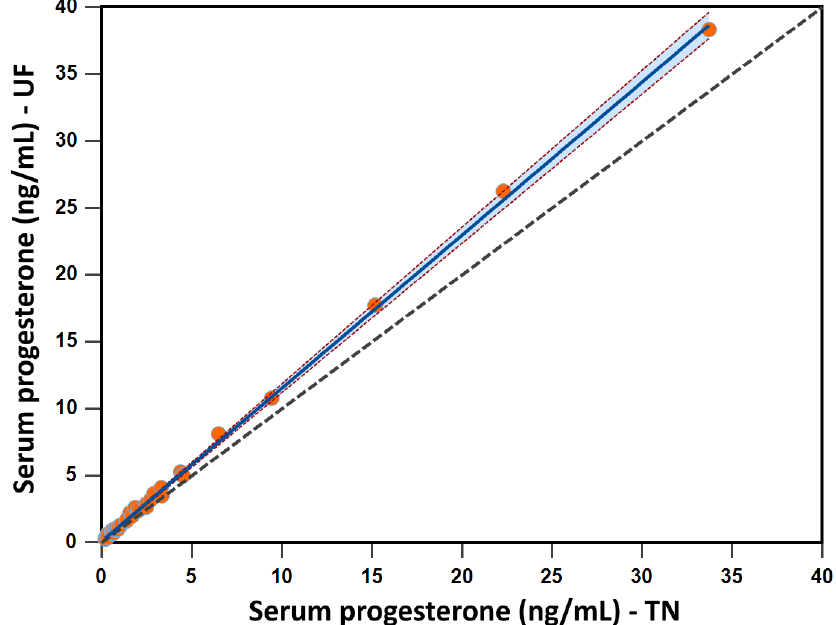
Figure 4. Scatterplot indicating the relationship between the serum progesterone concentration measured by the IMMULITE ® 2000 XPi P4 immunoassay at the University of Florida (UF) and the University of Tennessee (TN). The grey dashed diagonal line is the line of identity, and the solid blue line and dashed orange lines are the best fit from Passing–Bablok and the 95% CI, respectively. Bland–Altman analysis was used to measure the agreement between the two units